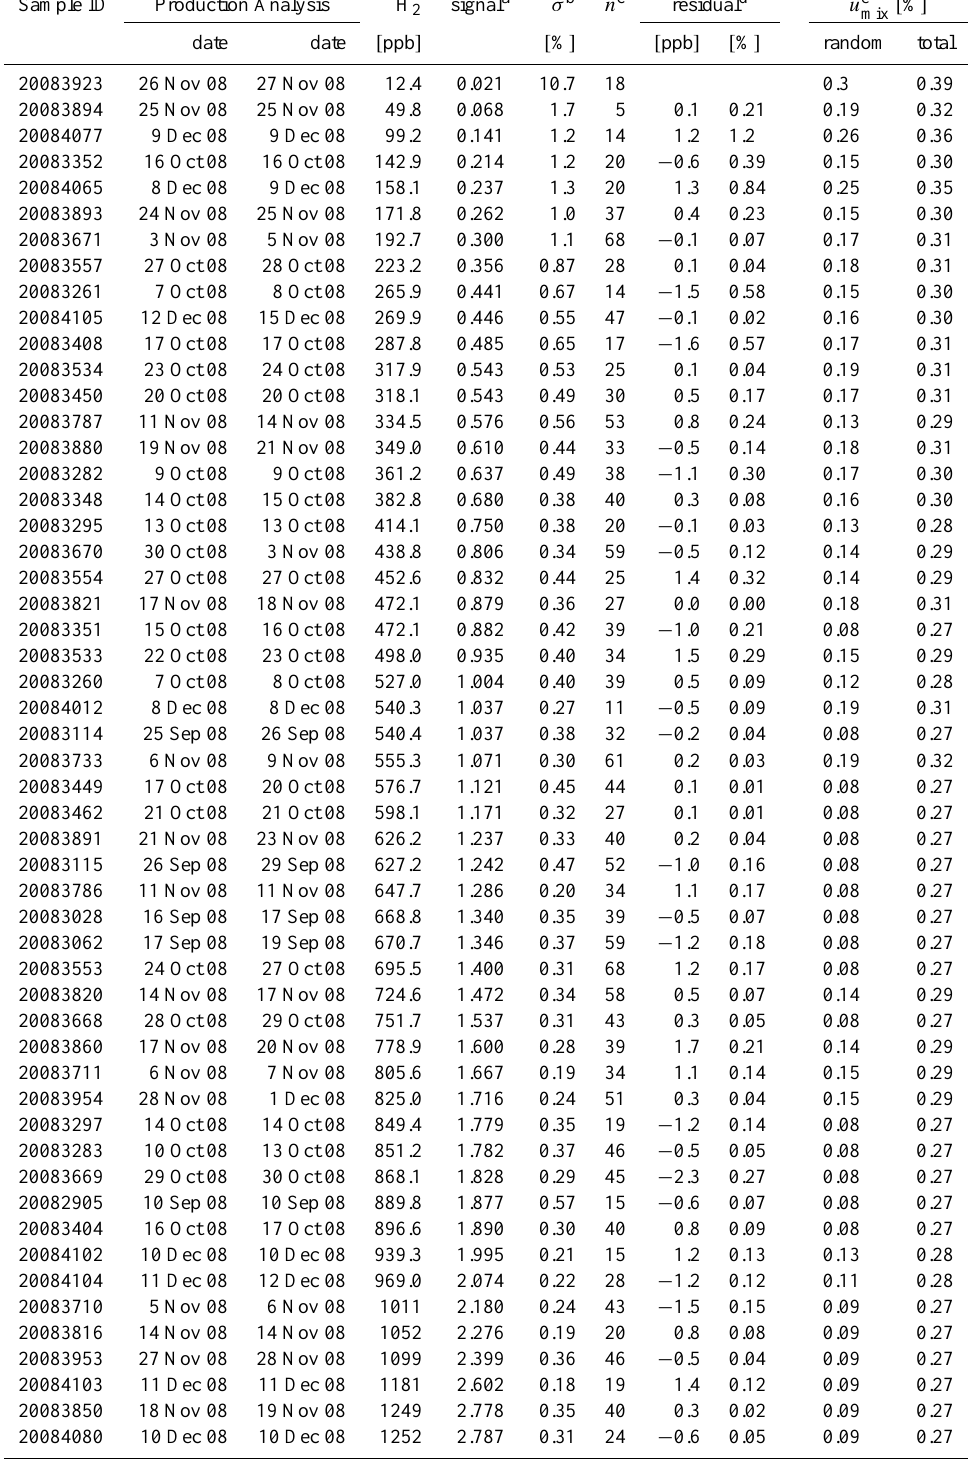
a signal=average normalized peak height relative to the working standard containing H b σ =relative standard deviation of the analysis, 2 =523.8ppb (SampleID 20061951), c n =number of GC-HgO-analysis, d residual=H 2 mixing ratio measured based on the calibration function (Eq. 3) – H 2 mixing ratio resulting from the moles of H 2 and moles of air mixed, e u mix =uncertainty of the mixing procedure: random=combined uncertainty of pressure, temperature and mass measurements, total=combined uncertainty of all parameters that influence the mixing procedure as specified in Table